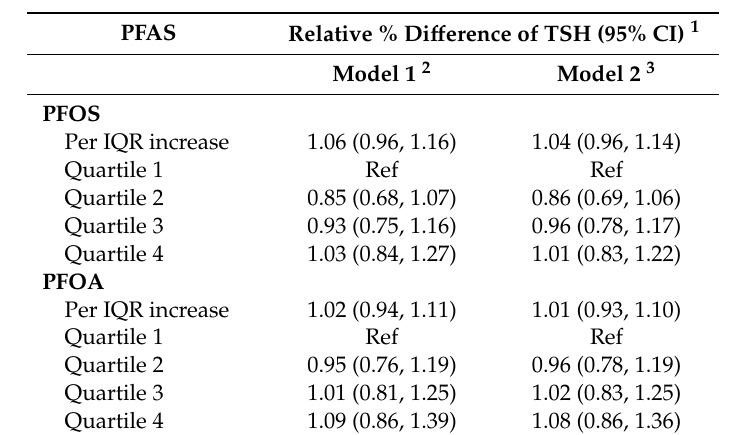
Table 1. Associations between plasma PFAS levels (ng / mL) and maternal thyroid hormone levels with or without adjustment of pre-pregnancy body mass index (BMI; n = 1366).